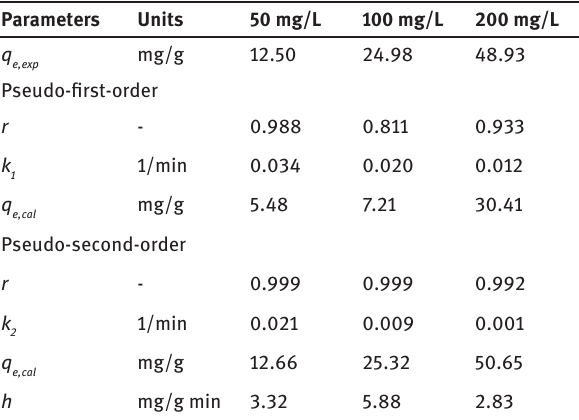
Figure 2: Pseudo-second-order (a) model fit for adsorption of CuPC on H. communis skeleton and fit of the experimental data to the Langmuir and Freundlich models (b). Table 1: Kinetic parameters of CuPC adsorption on H. communis